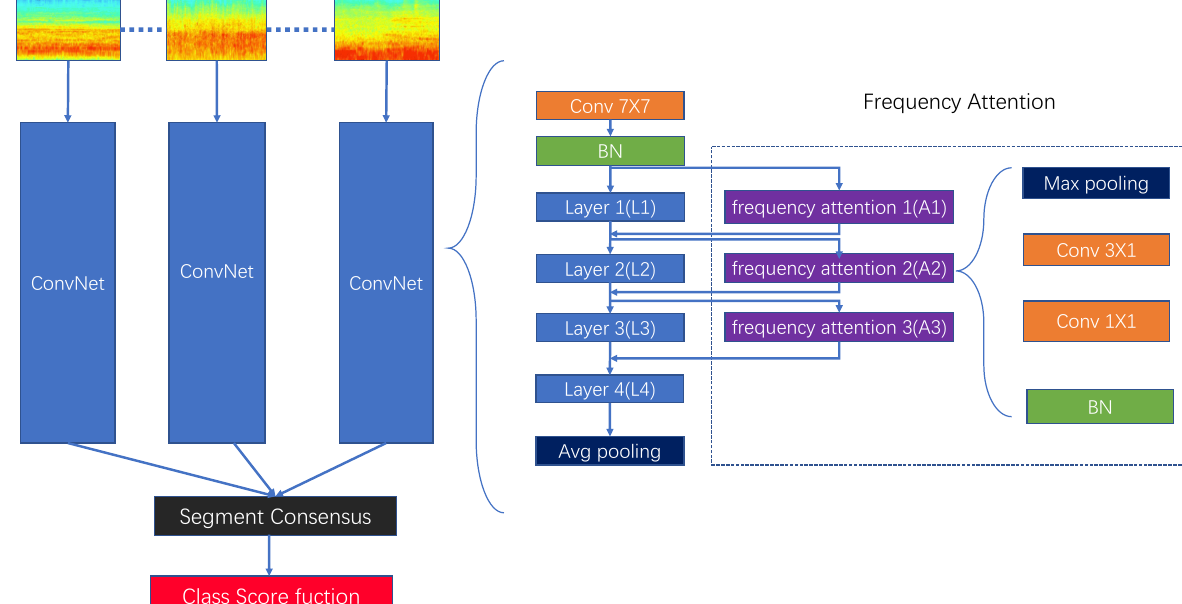
Figure 4. The RANet architecture for pornographic audio detection. Inspired by Temporal Segment Networks (TSN) [28], K log Mel-spectrograms are generated from the audio data and delivered into the RANet. In addition, the frequency attention which contains three attention blocks is used for capturing the most important information in frequency domain. Thus, the recognition scores of K log Mel-Spectrograms are fused by the segmental consensus function for porn audio